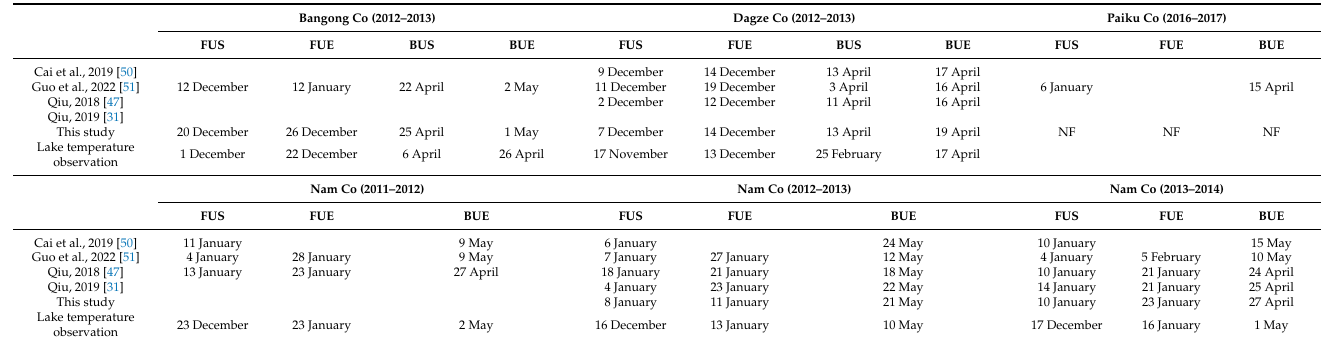
Table 2. Comparison of lake ice phenology datasets and lake temperature chain observations. NF is the abbreviation for not